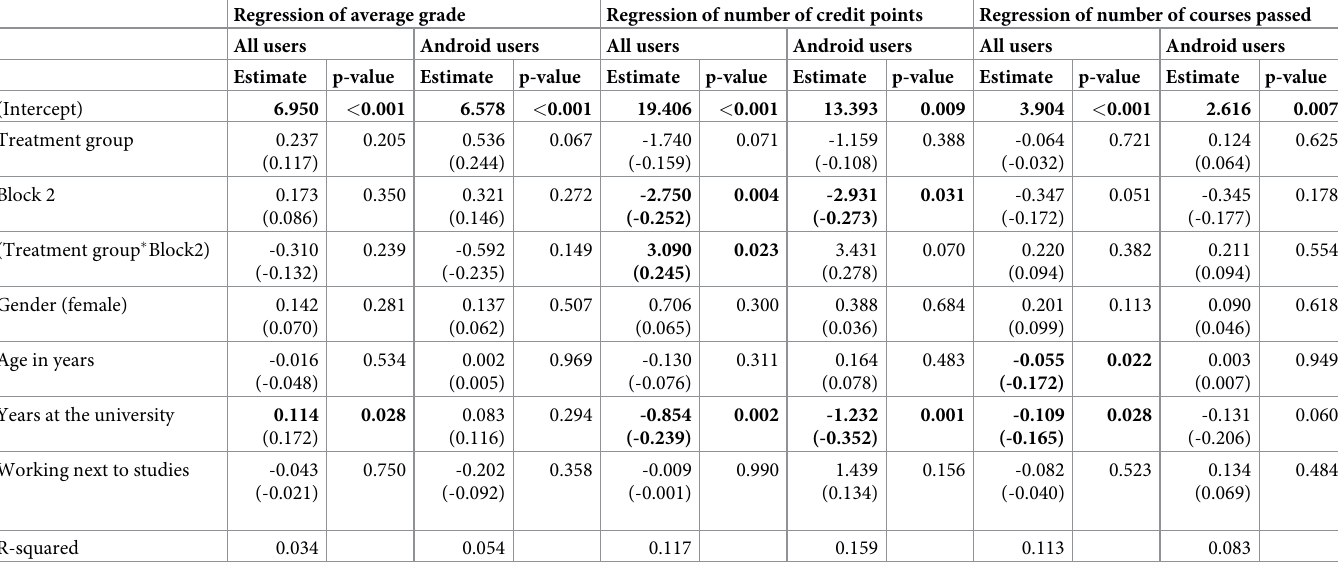
Table 7. Regression of academic performance (standardized coefficients in